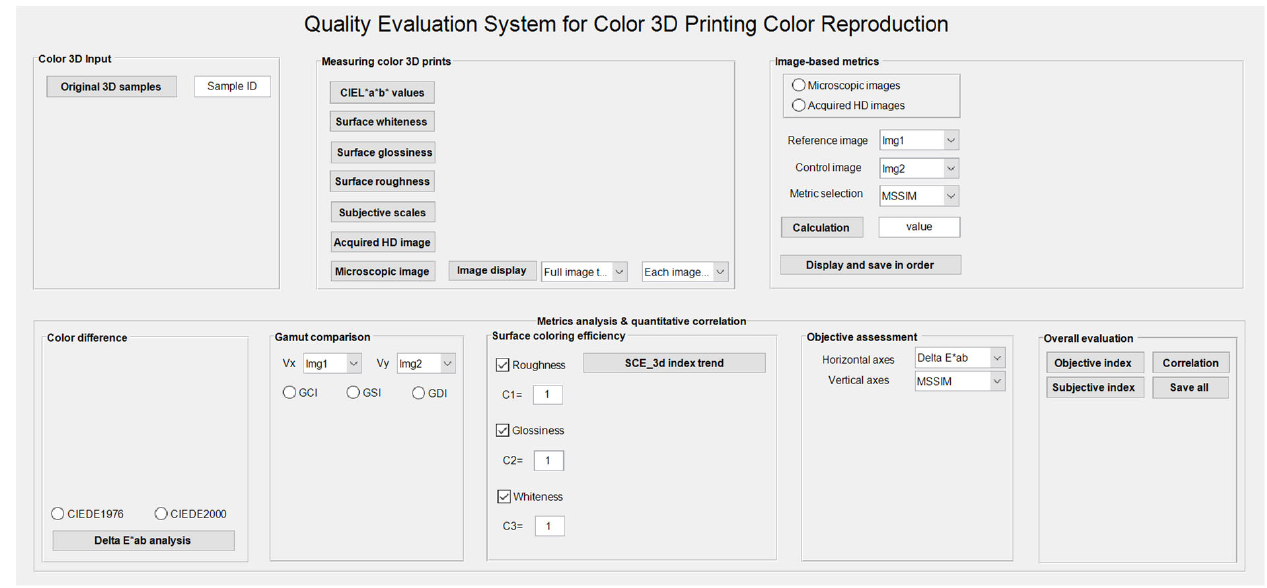
Figure 19. Overall interface design and initialization of the current system.